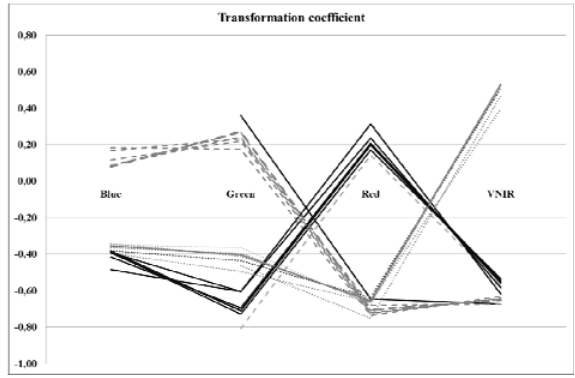
Fi gure 5. Distribution of the linear coefficient for each spectral bandwidth. Solid line shows the coefficients for the crop mark component, dashed line the coefficients for the soil component and dot line the coefficients for the vegetation component. In order to evaluate the proposed transformations for each sensor, different archaeological sites were evaluated. In